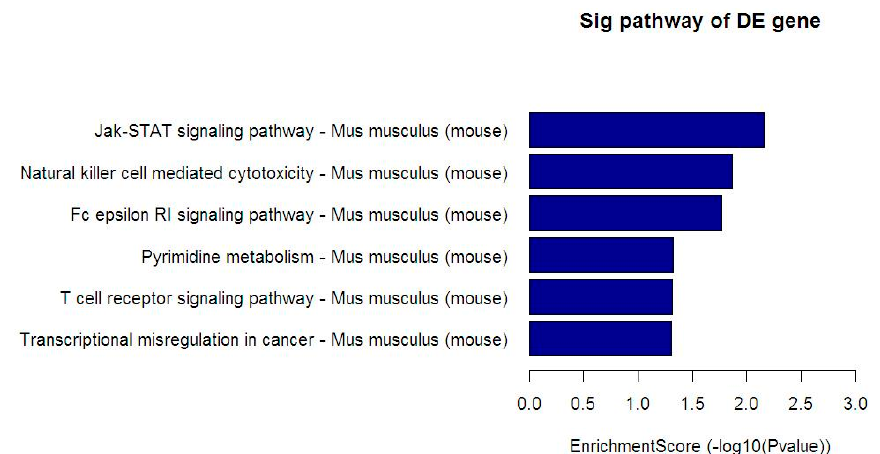
Figure 4. Kyoto Encyclopedia of Genes and Genomes (KEGG) pathway associated with HIF-1 α